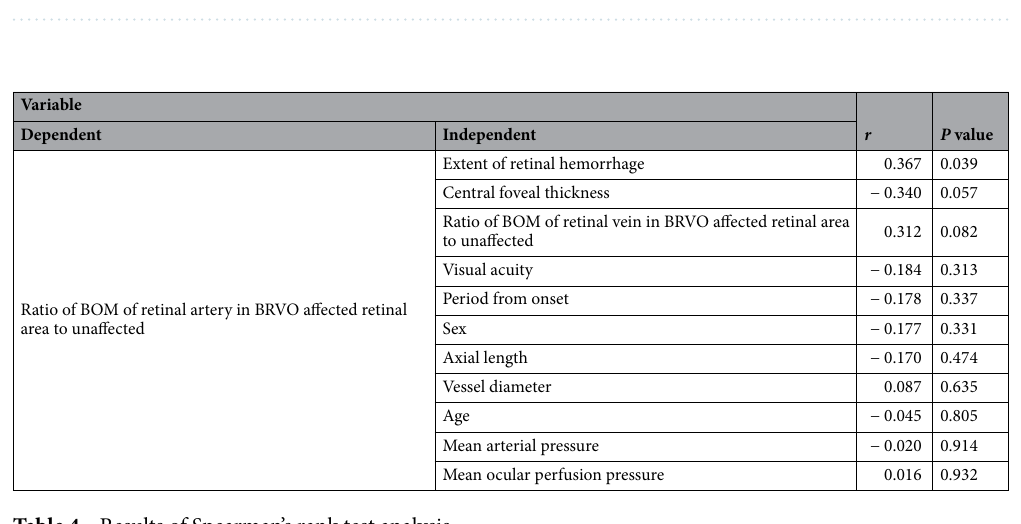
Figure 7. The ratio of BOM of a retinal artery in BRVO-affected retinal area to unaffected area was significantly higher in the major BRVO eyes than that in the macular BRVO eyes ( P = 0.003).